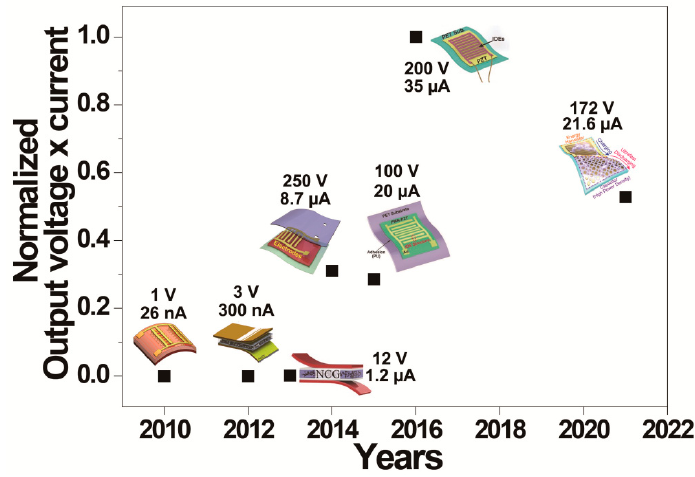
Figure 14. A summary on the output performance values of perovskite piezoelectric-based flexible energy harvesters over the last decade. The normalized output voltage and current values are calculated by multiplication of measured output open-circuit voltage and short-circuit current from bending motion of flexible piezoelectric energy harvesters. Reproduced with permissions.